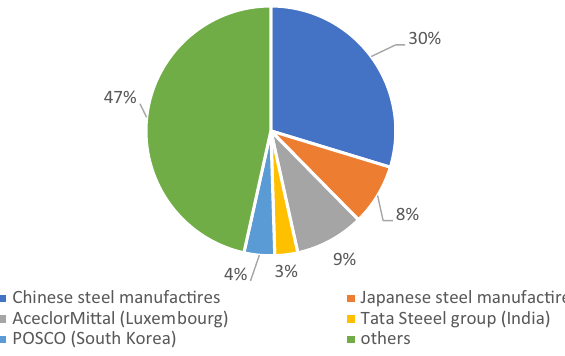
Fig. 1 Largest steel manufacturing companies, and shares of global production, 2019